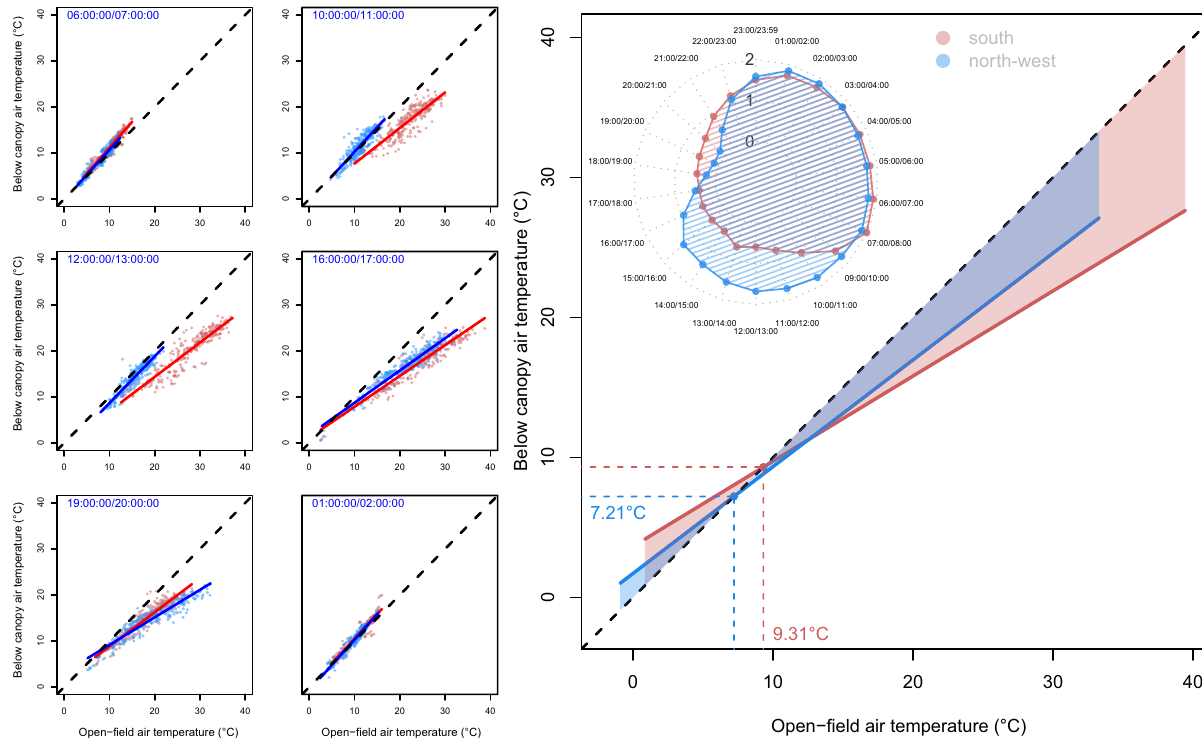
Figure 6. Relationship between near-ground open-field (set as reference) and below-canopy daily mean temperature of the growing season (from May to September). Blue and red circles represent the mean daily temperature of northwestern and southern treelines, respectively. The full line represents the linear regression fit (northwestern, blue line: intercept = 1.73, slope = 0.76; southern, red line: intercept = 3.65, slope = 0.60). The dashed black line represents the 1:1 relationship (temperature offset = 0 °C or below-canopy equals open-field temperature). Positive values (shaded pink area) indicate overall near-ground warmer conditions under the canopy than at the reference site, while negative values (shaded blue area) indicate cooler air under the canopy than reference conditions. Radar inset plot shows the hourly slope of the fitted lines. Full statistics are reported in Supplementary Material Table